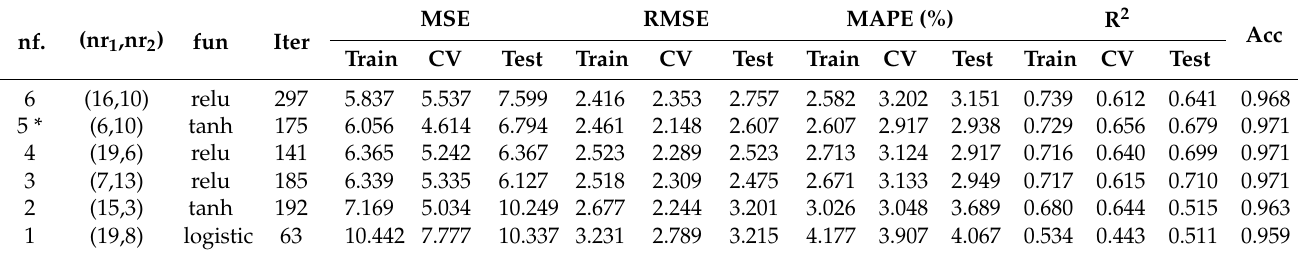
Figure 7. The texture features selected during neural network training loops. Table 5. Various architectures of BPNN model based on GLCMF extracted from digital images with MSE, RMSE, MAPE (%), Acc, and R 2 in training, cross-validation, and test